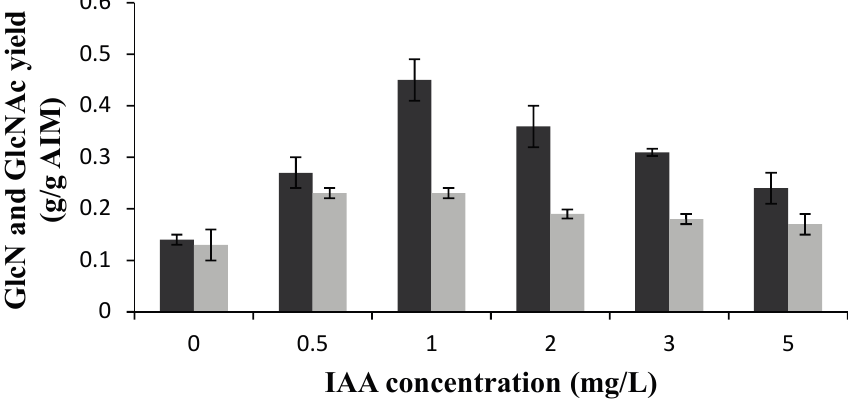
Figure 1. Effects of different concentrations of indole-3-acetic acid (IAA) (mg/L) on glucosamine (GlcN) (black bars) and N -acetyl glucosamine (GlcNAc) (gray bars) yields. Error bars represent the standard deviations of values obtained from at least two independent